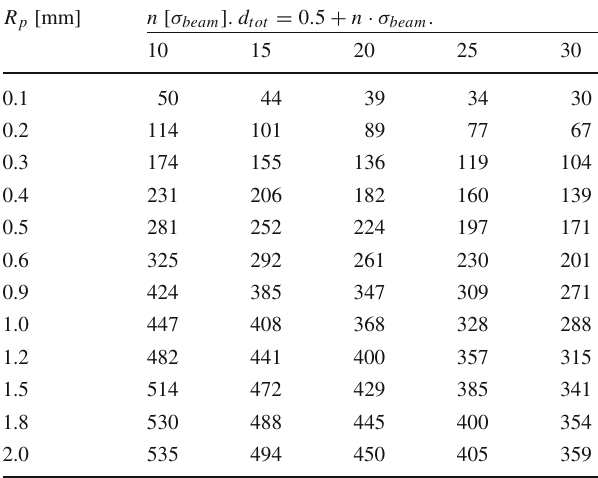
Table 2 The signal visible cross-section in nanobarns as a function of R p and d tot = 0 . 5 + n · σ beam for the LHC running with β ∗ = 90 m